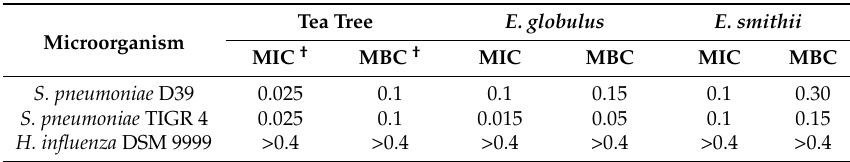
Table 4. Minimum inhibitory concentration (MIC) and minimum bactericidal concentration (MBC) values for Eucalyptus and tea tree EOs §